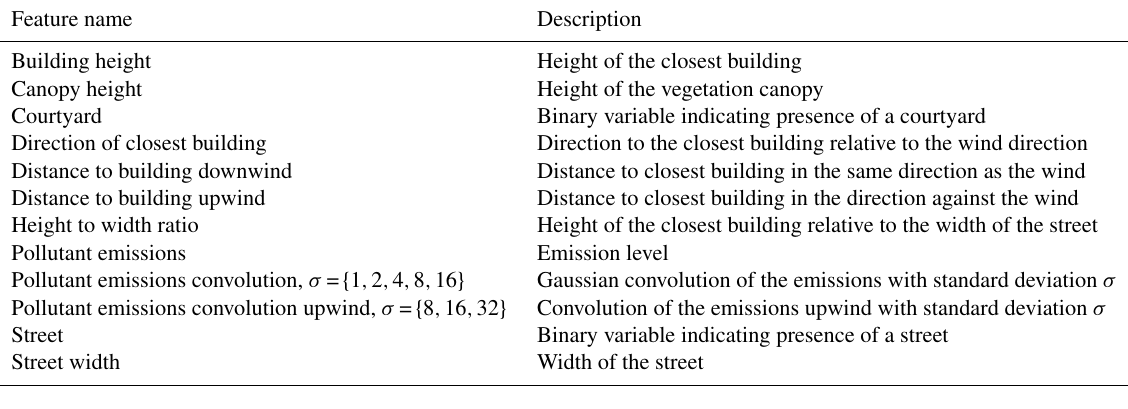
Table 1. List of features used in the regression models.